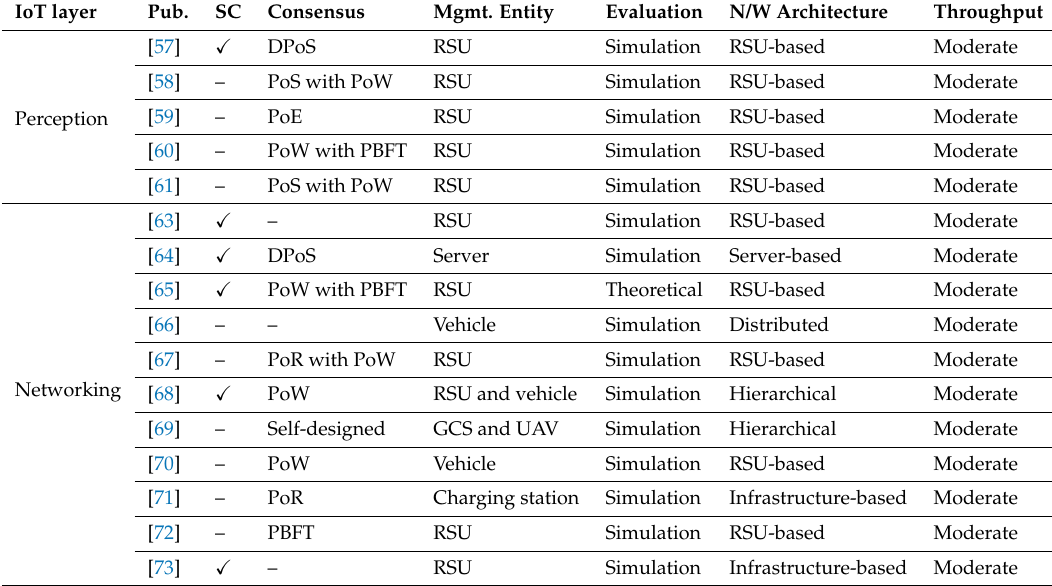
Table 6. Main characteristics of existing blockchain studies. Pub., publication; SC, smart contract; Mgmt., management; N/W,